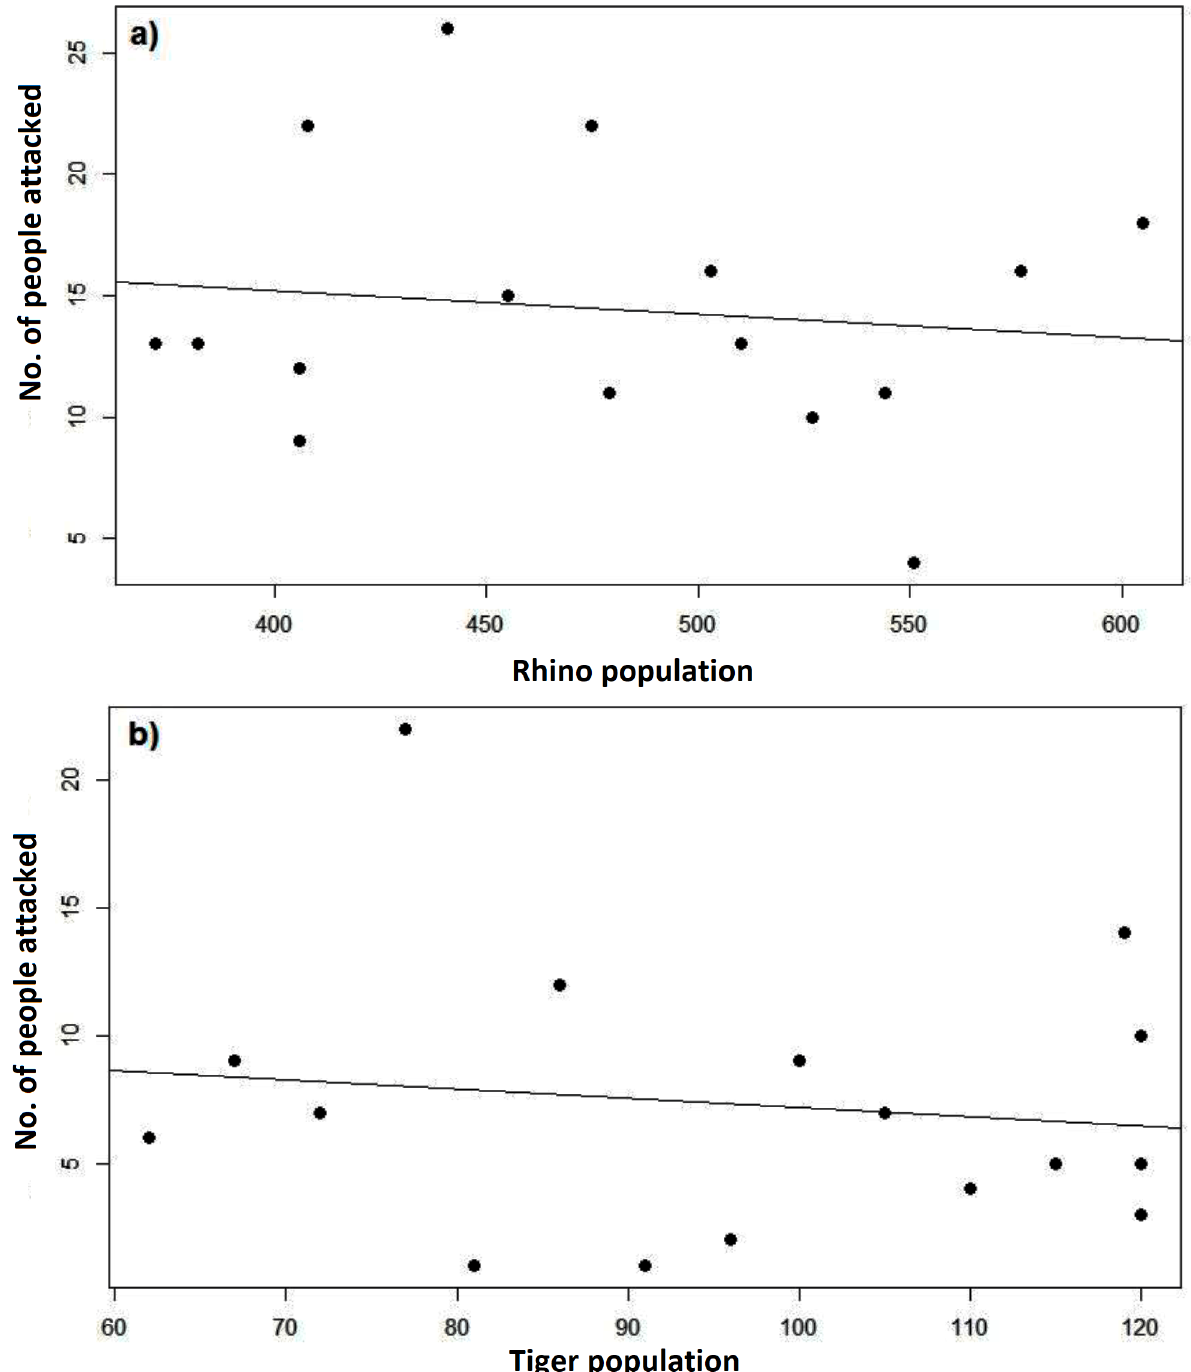
Fig 4. Number of attacks on humans (y-axis) plotted over the population of a) rhino and b) tiger in x-axis. https://doi.org/10.1371/journal.pone.0195373.g004 observed (Fig 5). Five of 22 BZUCs of Chitwan recorded > 50% of human deaths and 13 BZUCs reported five or more human deaths in their area. The highest number of human kill- ing (24) was recorded from Ayodhyapuri BZUC in Madi valley (south of the park) followed by Kalabanjar BZUC (18).